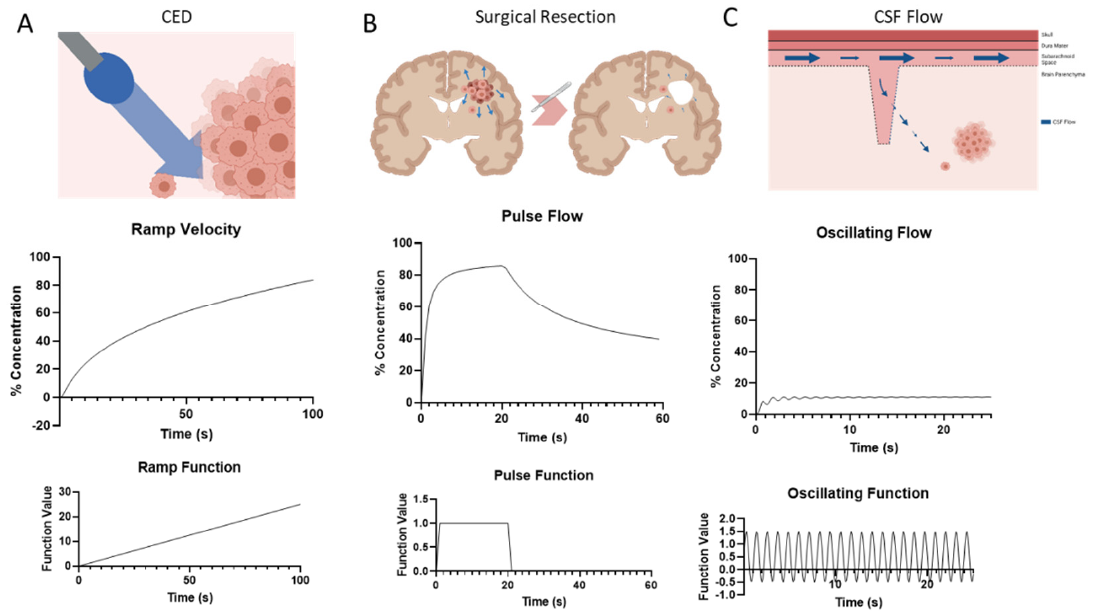
Figure 3. Transient solutions of gradient formation around single cells based on physiological time-dependent changes to superficial flow rate. ( A ) Schematic of CED increasing fluid flow ( top ) followed by the resulting concentration gradient over time ( middle ), and the ramp function input into COMSOL ( bottom ). ( B ) Schematic of surgical resection impact of fluid flow ( top ), the resulting concentration gradient over time ( middle ), and the pulse function input into COMSOL ( bottom ). ( C ) Schematic of oscillating CSF flow coming from the Virchow-Robin space into the parenchyma and interacting with tumor cells ( top ), the resulting concentration gradient over time ( middle ), and the oscillating function input into COMSOL ( bottom